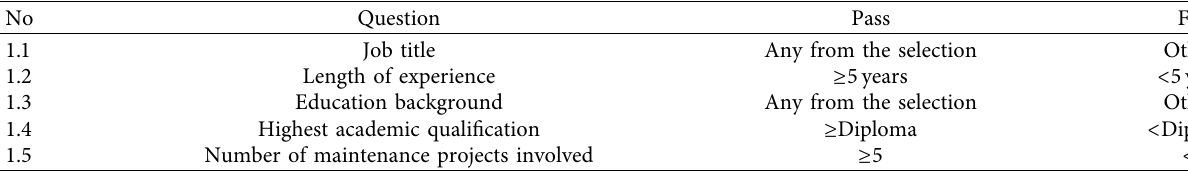
Table 1: Requirements to pass the screening questions.